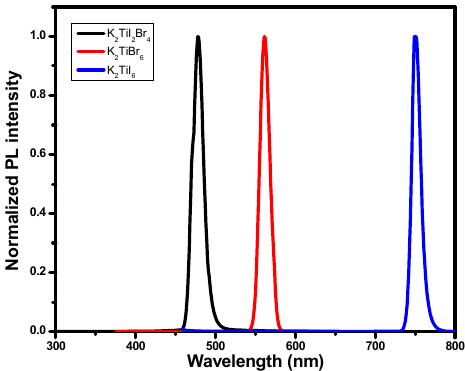
Figure 5. PL spectra of K 2 TiI 2 Br 4, K 2 TiBr 6 , and K 2 TiI 6 .